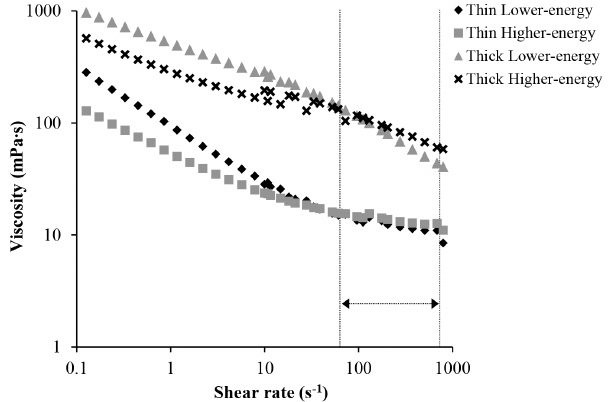
Figure 1. Viscosity of the four test drinks under shear. The section marked with an arrow represents viscosity measured between shear rates 80–700 s 2 1 , which are thought to best represent speeds associated with the perceived viscosity of fluids [38].